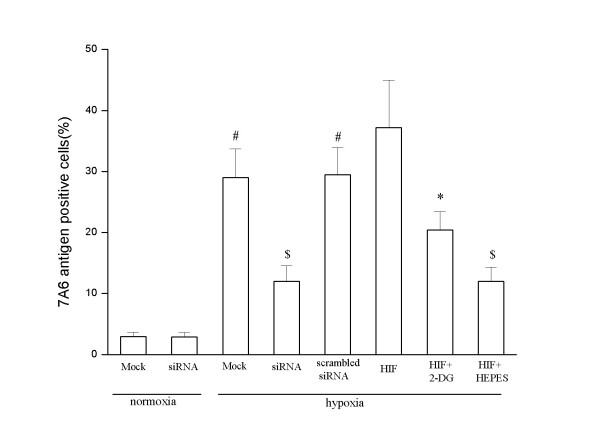
Detection of apoptosis by flow cytometry: graphical format. Cells were treated and stained as described for Fig. 7. Shown is a graphical representation of this data with statistical analysis from a representative of 5 independent experiments. $, P < 0.05 compared to normoxic mock transfected and HIF-1α siRNA; *, P < 0.05 compared to hypoxic HIF-1α siRNA and HIF-1α expression vector with HEPES; #, P < 0.05 compared to hypoxic HIF-1α expression vector with or without 2-DG. siRNA: A549 cells transfected HIF-1α siRNA vector, Mock: mock-transfected, HIF: A549 cells transfected with HIF-1α expression plasmid, HIF+2-DG: Cells transfected with HIF-1α expression plasmid and cultured with 2-DG, HIF+HEPES: Cells transfected with HIF-1α expression plasmid and cultured with medium containing HEPES.